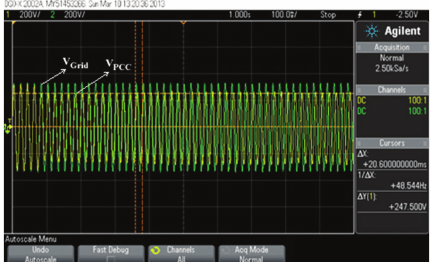
Figure 10: Experimental results of inverter while 𝑃 = 1 kW and 𝑃 =